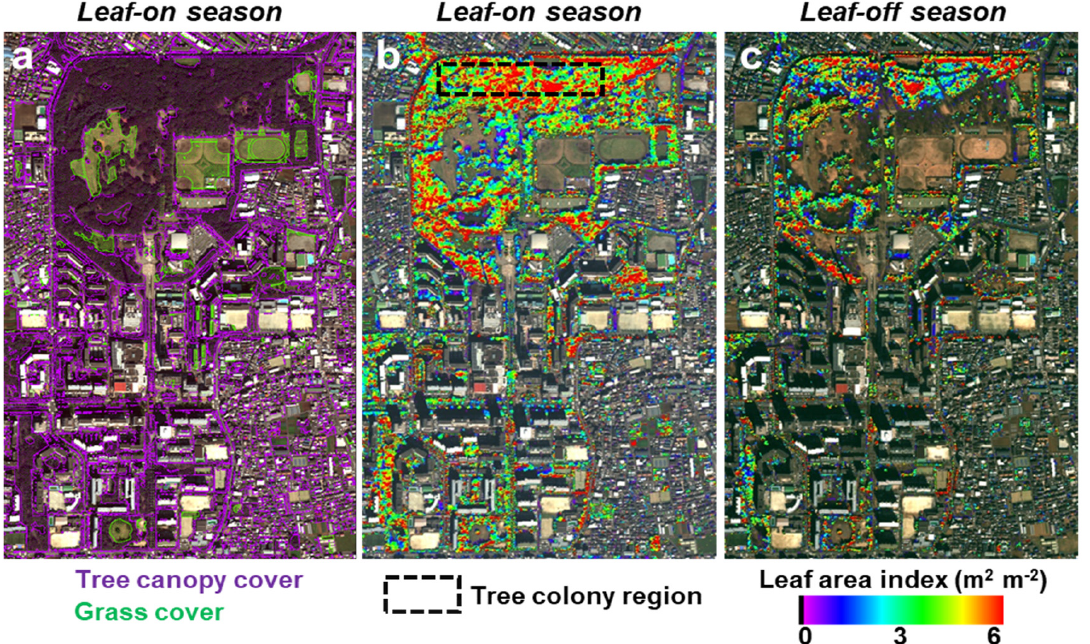
Figure 8. Example of mapping results of tree canopy leaf area in the test area shown in Figure 2 ( A1 and B1 ). ( a ) Vegetation cover according to the Tokyo GWC-ratio data based on aerial photograph. Estimated map of tree leaf area index (LAI; m 2 m − 2 ) for leaf-on season ( b ) and leaf-off season ( c ). Satellite imagery from DigitalGlobe Products. ( a–c ) WorldView2 © 2020 DigitalGlobe, Inc., a Maxar company. Table 5. Comparison of the total tree canopy leaf area (km 2 ) estimated in Figure 8 and all Tokyo special wards from the satellite images (WorldView-2/3, Landsat5-TM, and Landsat8) and the respective LAI − VI models.